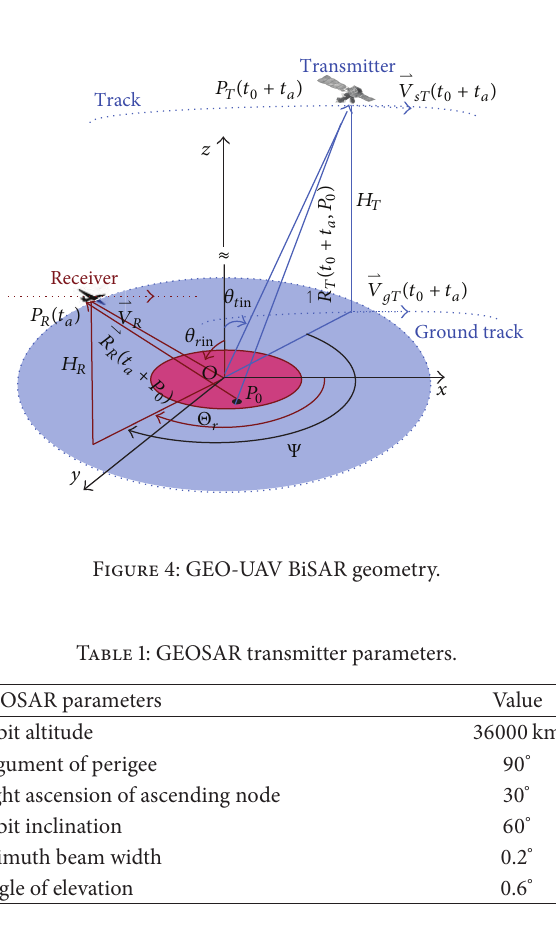
Figure 3: The range acceleration (a) and the azimuth acceleration (b) of GEOSAR ground track in local ground coordinate system.